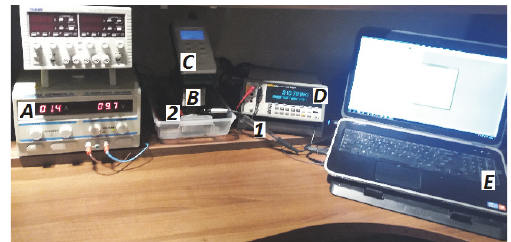
Figure 6: Image of the experimental setup: A, source of continuous current; B, electromagnet; C, Gaussmeter; D, RLC bridge; 1, hall probe; 2, hMRE; E, computing unit.